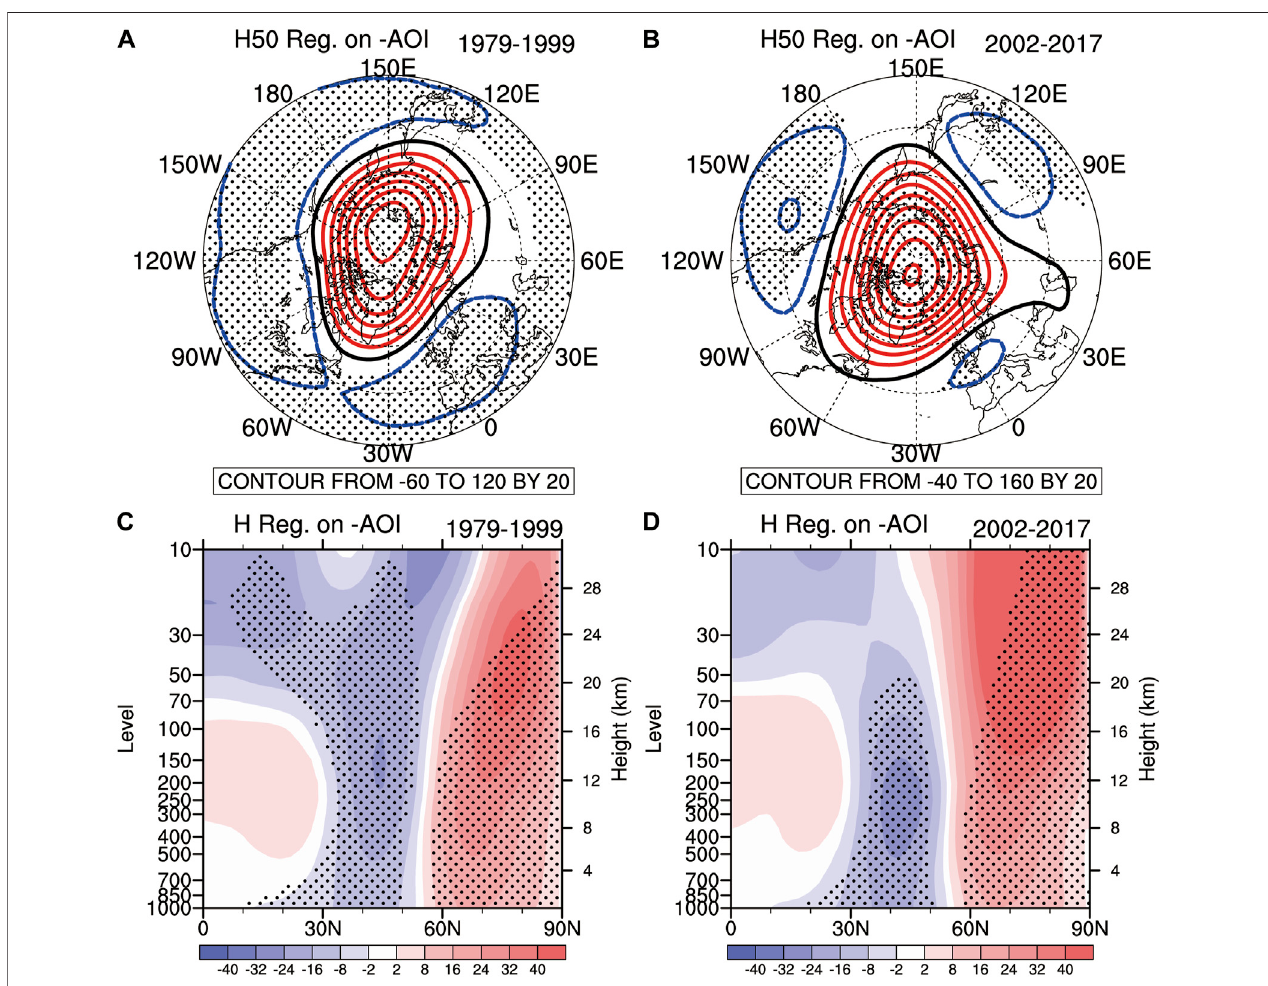
FIGURE 11 | (A, B) Regression maps of the geopotential height (units: gpm) at 50 hPa upon − AOI during (A) 1979 – 1999 and (B) 2002 – 2017. (C, D) Also shown are regression maps of the cross-section of the geopotential height (units: gpm) averaged zonally within the North Atlantic (90 ° W – 30 ° E) during (C) 1979 – 1999 and (D) 2002 – 2017 upon − AOI. The dotted areas indicate statistical signi fi cance at the 95% con fi dence level based on the Student ’ s t -test.